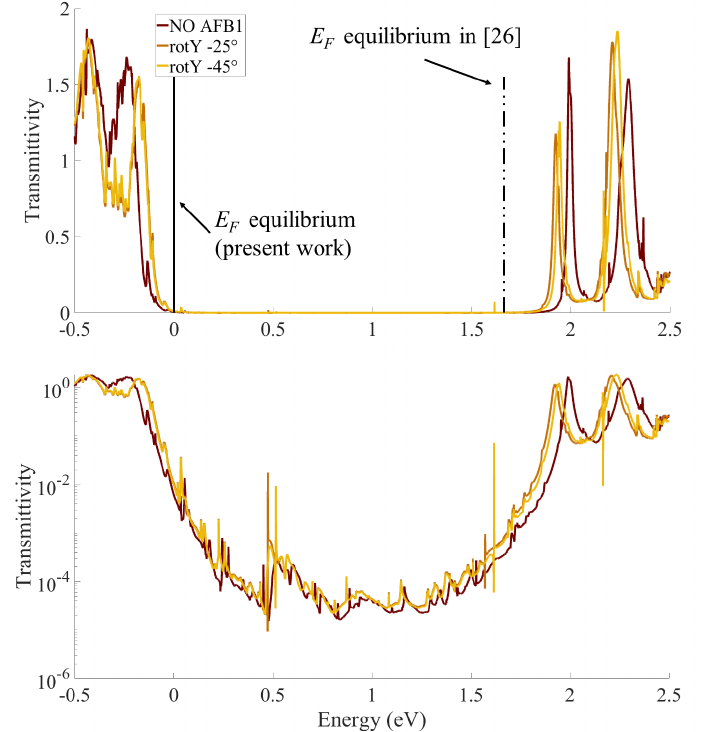
Figure 6. Computed equilibrium transmission spectra, TS ( E ) , in the linear and semi-logarithmic scales, of an Au-8PyDT FET sensor with (dark red) and without the AFB1 target. The brown and yellow TS ( E ) s correspond to the two most stable configurations of the Au-8PyDT sensor in the presence of the target, i.e., an x -rotation of − 25 ◦ and − 45 ◦ , respectively. The effect of AFB1 in both rotY − 25 ◦ and rotY − 45 ◦ configurations reduces the